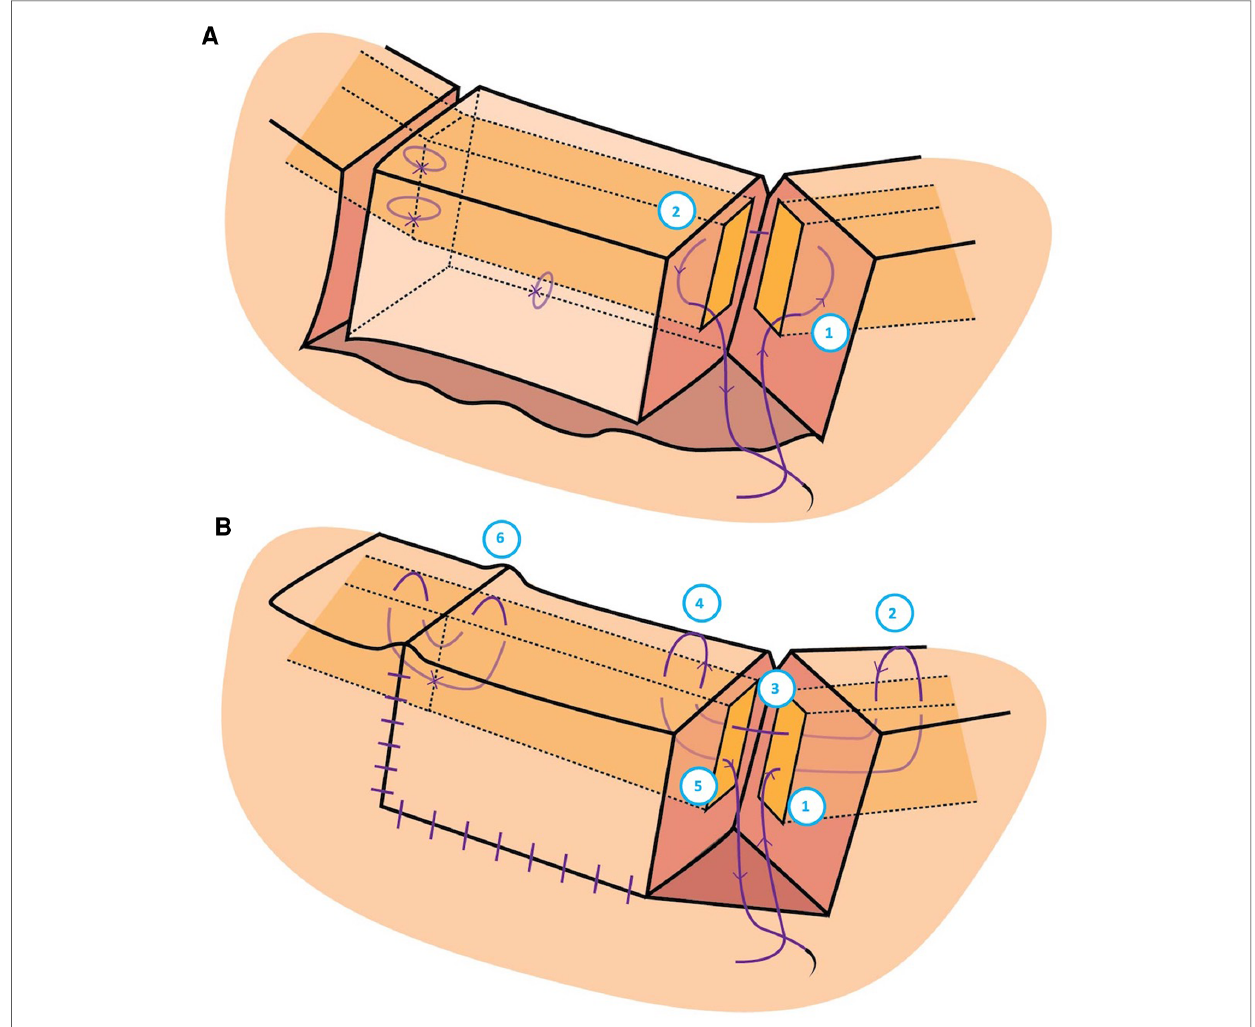
FIGURE 2 Graphic illustration of the suturing technique used to secure the donor eyelid to the host eyelid. ( A ) The needle was passed: (1) at the surgical incision of the host just anterior to the tarsus but posterior to skin, through the host tarsus, and exiting just posterior to the tarsus but anterior to the palpebral conjunctiva to create a buried suture, then (2) at the surgical incision of the donor just anterior to the palpebral conjunctiva and posterior to the tarsus, through its tarsal plate and exiting just posterior to the eyelid skin. ( B) The needle was passed: (1) Through the vertical edge of the host tarsus about 4 mm vertically from the eyelid margin, through the tarsus towards the palpebral fi ssure, aiming for the grey line of the host margin about 3 mm horizontally from the vertical incision; (2) Through the host grey line aiming back into the host tarsus; (3) Out of the host tarsus and into the donor tarsus about 2 mm vertically from the eyelid margin; (4) Back through the donor grey line of the eyelid margin; and (5) Passed back into the tarsus, coming out at the same level it went in to the host lid; (6) Creating a raised host-donor